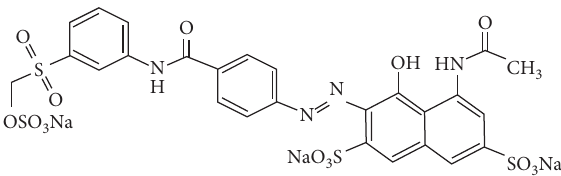
Figure 1: Chemical formula of the RR21